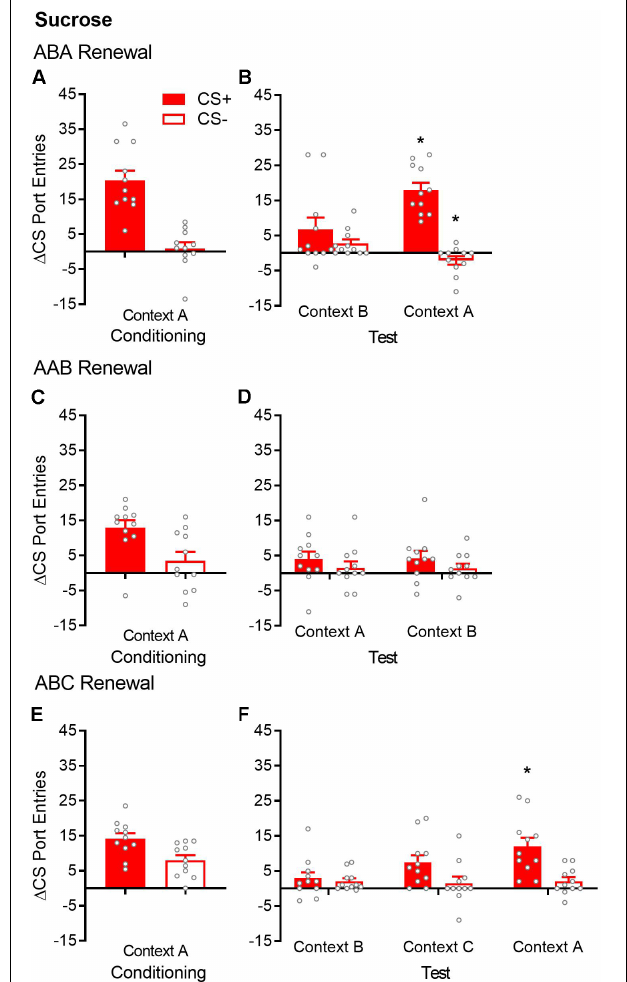
FIGURE 2 | ABA but not AAB or ABC renewal of Pavlovian conditioned responding in sucrose-trained rats. (A,C,E) Average port entries during the CS+ (red bars) and CS– (white bars) across the final session of Pavlovian discrimination training and retraining in context A in the ABA, AAB, and ABC renewal experiments. In all cases, CS+ port entries were significantly higher than CS– port entries. (B) In the ABA renewal experiment, CS+ port entries at test in context A were significantly elevated compared to the control test in context B. (D) There was no evidence of AAB renewal. (F) In the ABC renewal experiment, CS+ port entries were significantly higher at test in context A relative to extinction in context B, indicative of ABA renewal. CS+ port entries at test in context C did not differ significantly from either extinction in context B or test in context A. All data are mean ± SEM (cid:49) CS port entries (CS minus pre-CS). n = 11 per experiment. Data from individual rats are overlaid as symbols on the bar graphs. * p < 0.05 for a Bonferroni-corrected post